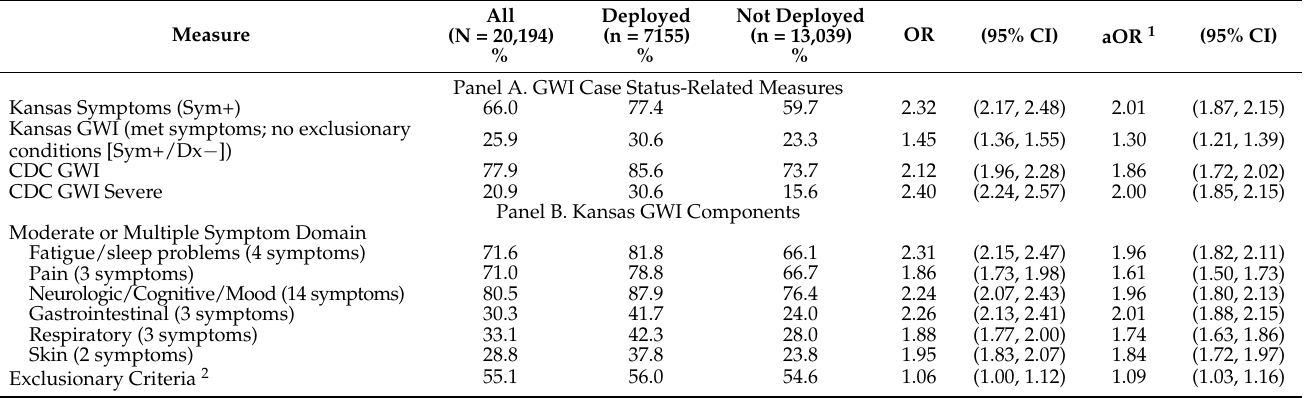
Table A6. Complete Case Analyses for Associations of Gulf War Illness Phenotypes with 1990–1991 Gulf War Deployment